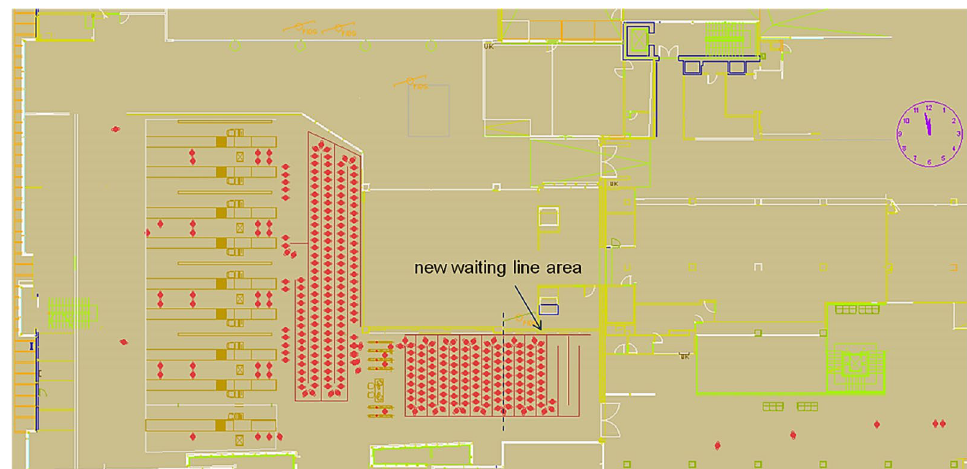
Figure 12. Visualisation of results for Scenario